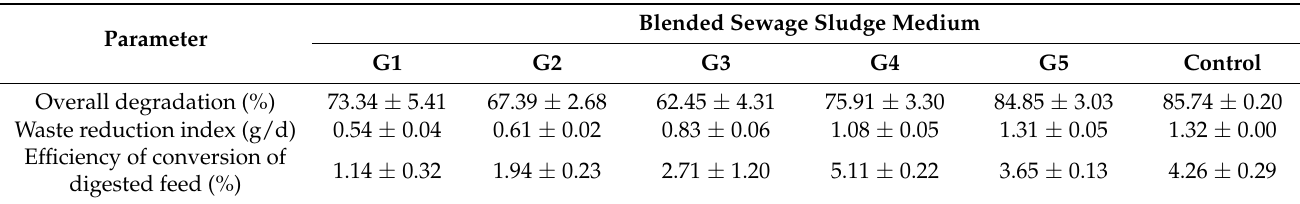
Table 1. Valorization of various blended sewage sludge ratios by